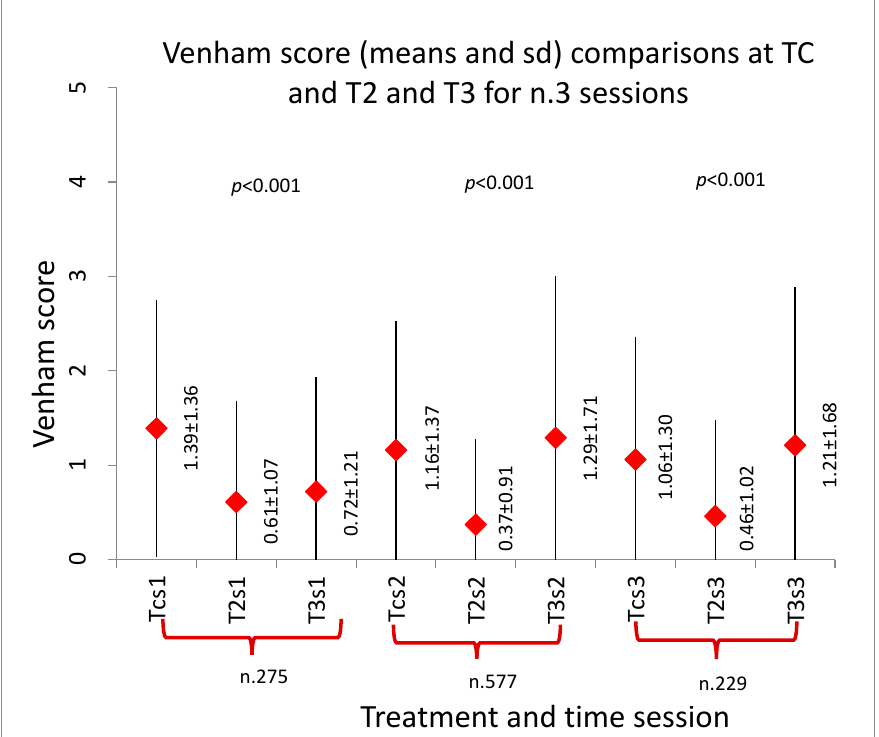
Figure 3. Venham score comparisons between Tc, T2 and T3 in the three sedations (s1, s2 and s3). Tc: first contact with the dentist. T2: during the administration of local anesthesia. T3: during the dental treatment.